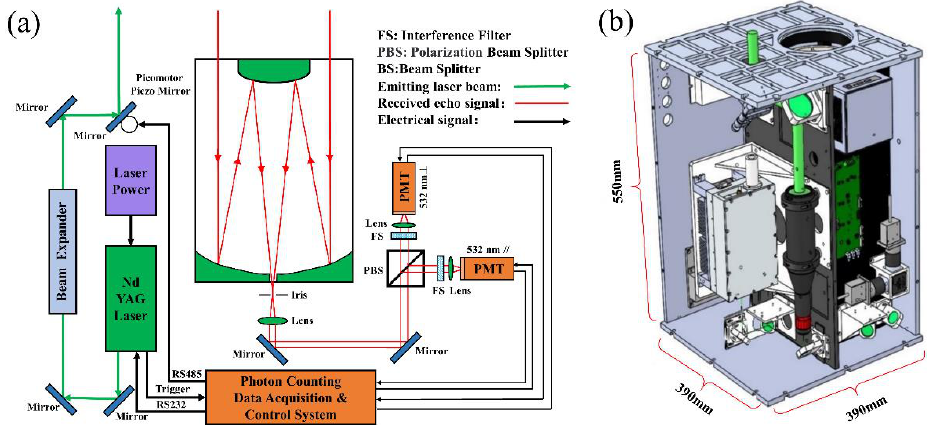
Figure 1. Lidar sensor system: ( a ) schematic diagram and ( b ) internal structure diagram.